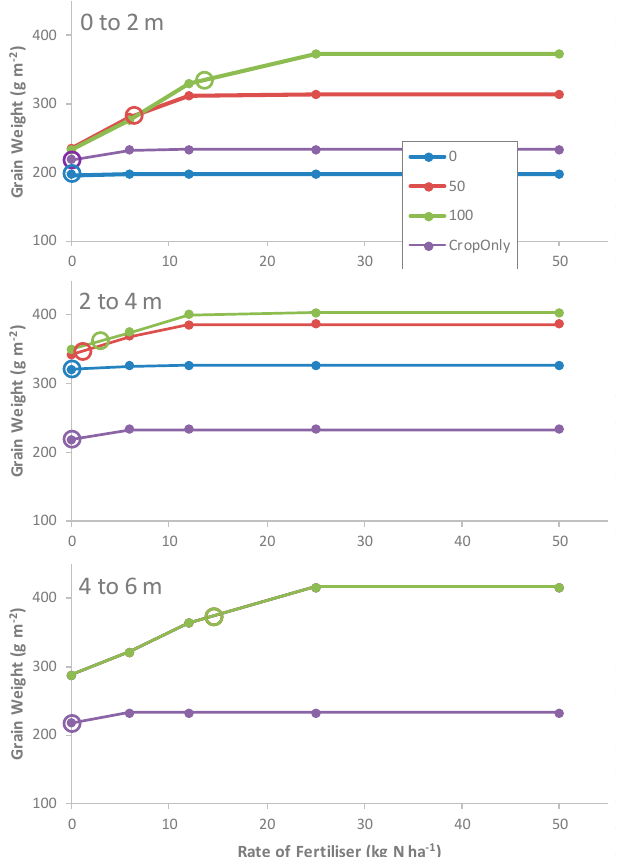
Figure 2. Simulated maize yield response to rates of N in crop-only and under-tree zones (0–2 m, 2–4 m, and 4–6 m) for 100% pruned, 50% pruned, and unpruned conditions in the 2016 cropping season. Circles indicate yield at the optimum fertilizer rate. Simulated values for all pruning levels in the 4 to 6 m zone (0%, 50%, and 100% pruning) were approximately identical and therefore indistinguishable on the graph.